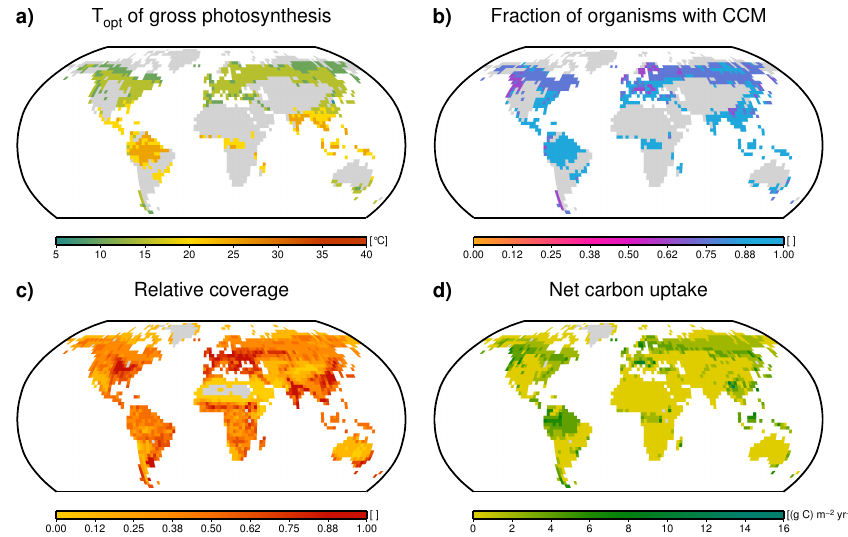
Figure A.2: a) to c) are global maps of model estimates derived by time averages of the last 100 yr of a 2000-yr run with 3000 initial strategies and they are based on the “average” weighting method. a) and b) show optimum temperature and CCM fraction of lichens and bryophytes living in the canopy, which adds to Fig. 6, where the corresponding estimates for the ground are shown. In c) the fraction of available area covered by lichens and bryophytes is shown, which is highest in regions where available area on ground is limited due to agriculture. In d) carbon uptake by lichens and bryophytes is shown for a 400-run with 300 initial strategies. This run is used for the sensitivity analysis. The estimate is based on the “average” weighting method. Areas where no strategy has been able to survive are shaded in grey.